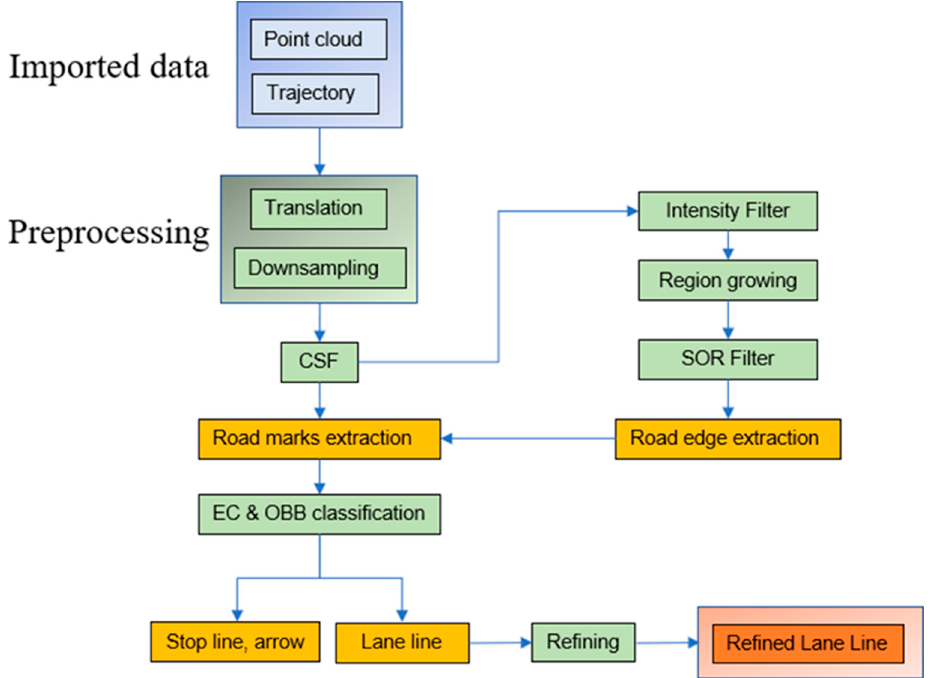
Figure 3. Flowchart of the extraction